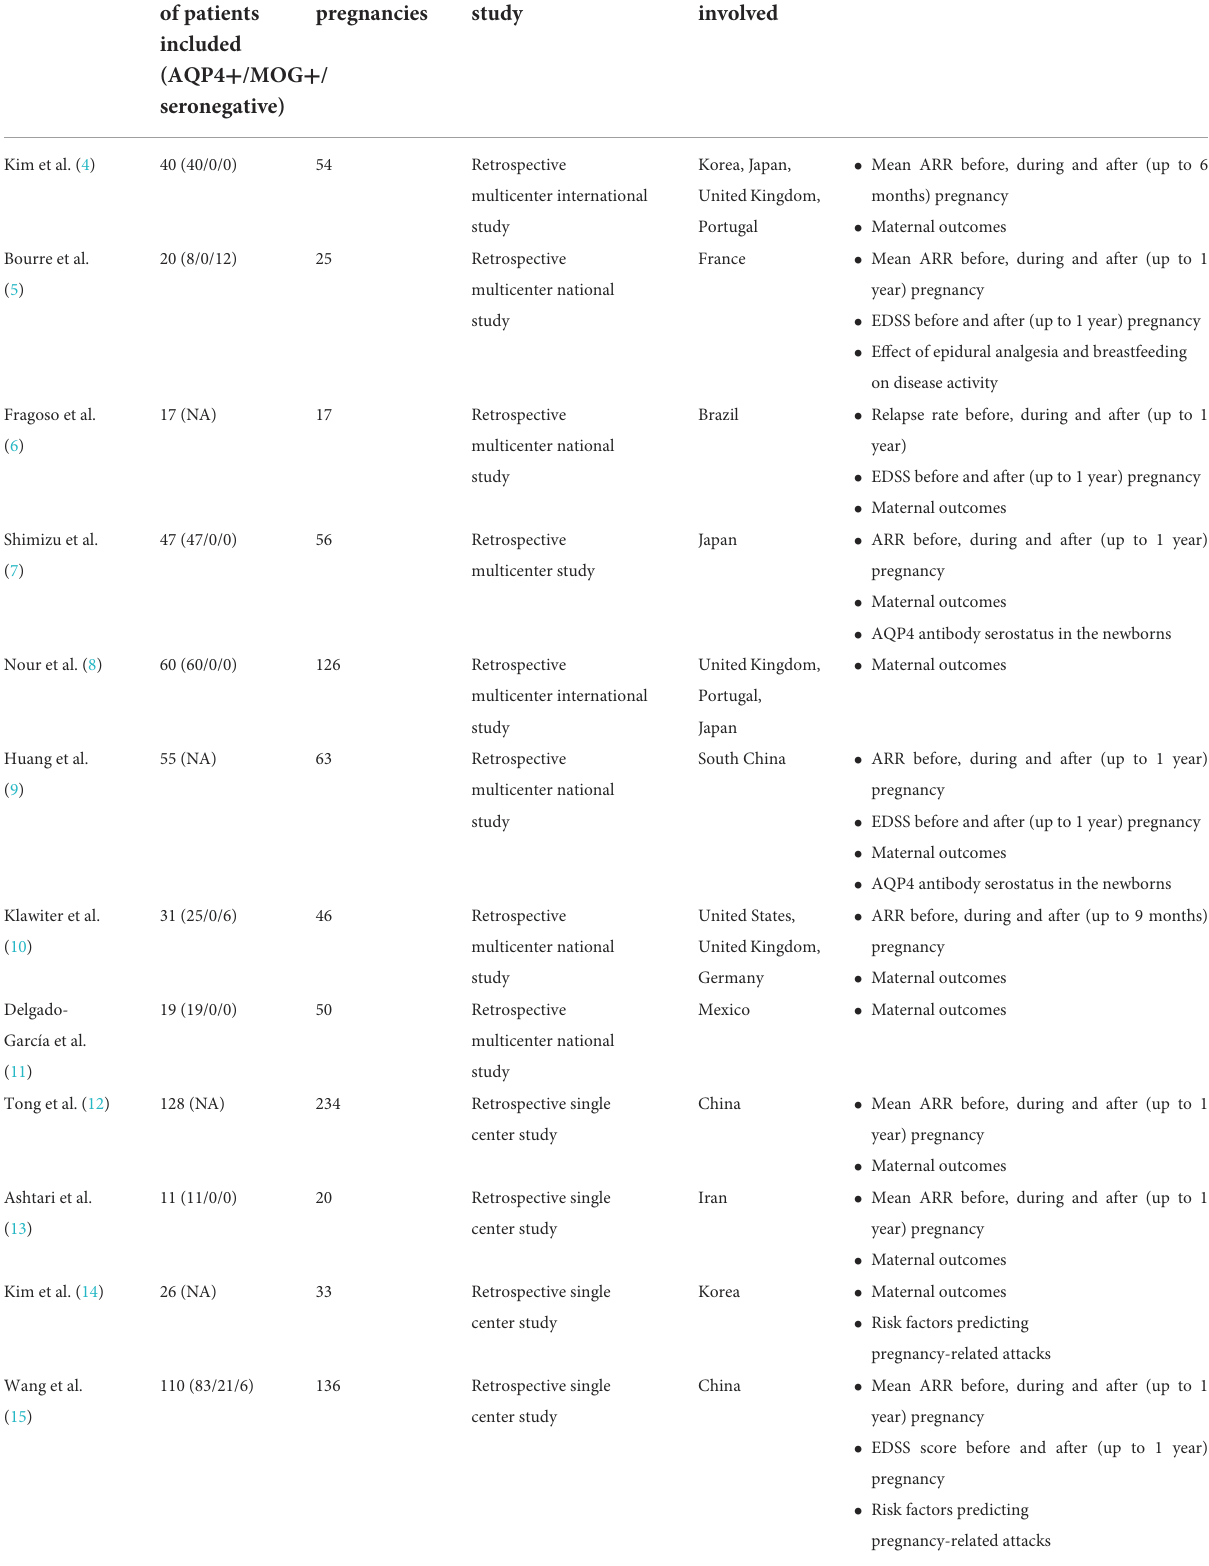
TABLE 1 Currently available studies assessing the relationship between aquaporin 4 (AQP4) and myelin-oligodendrocyte glycoprotein (MOG) antibody-mediated disorders of the central nervous system (CNS) and